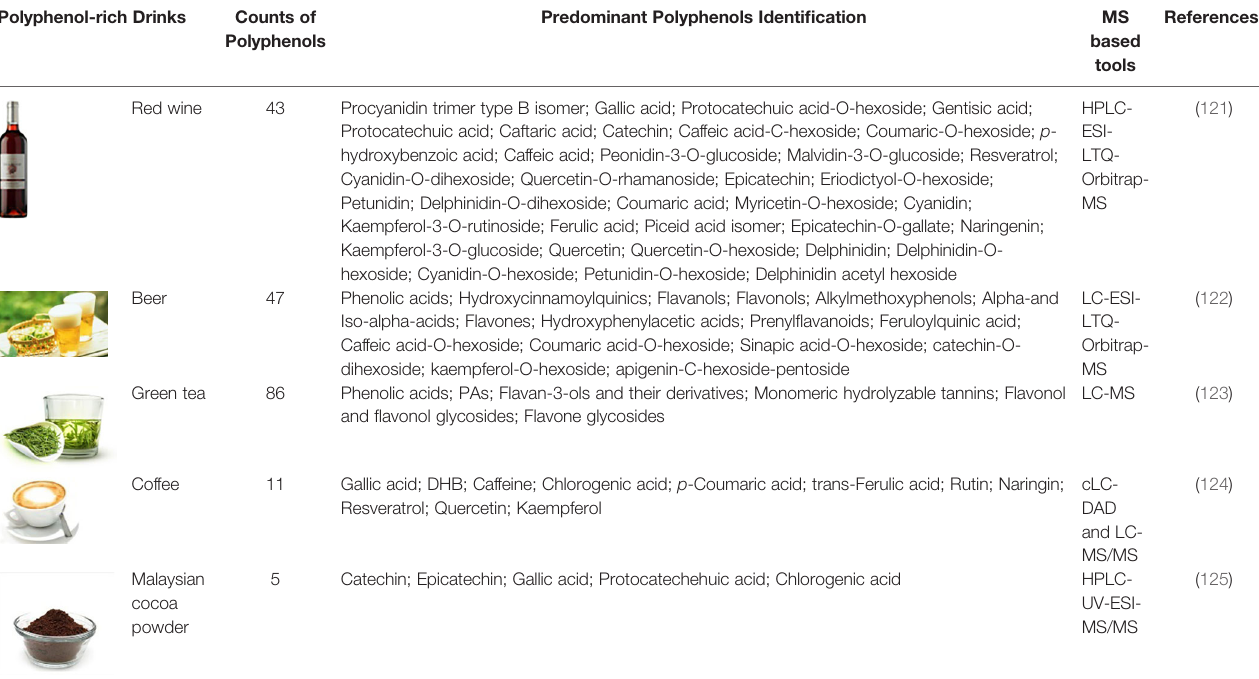
TABLE 1-2 | MS-based foodomics applied to the determination of polyphenolic active compounds in grain and oil. Polyphenol-rich